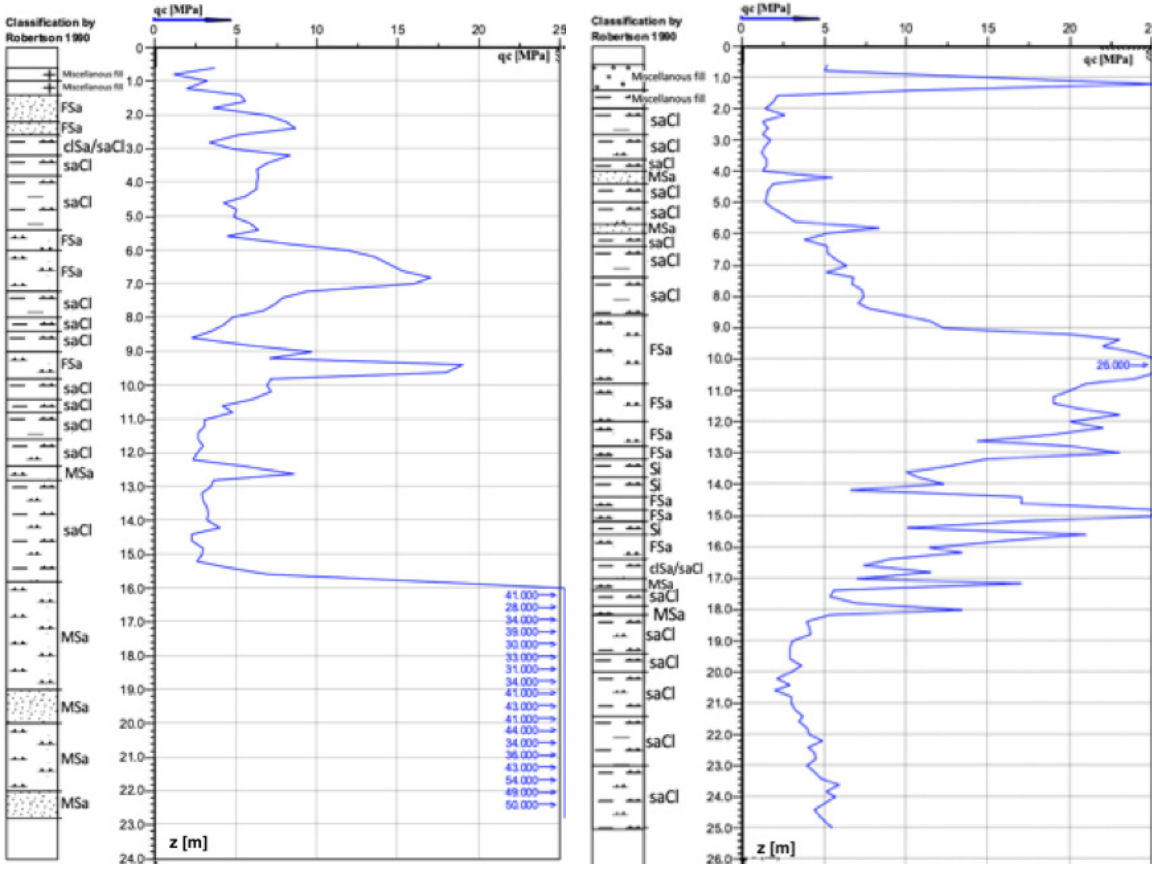
Figure 3: Graph of CPTu investigation results for Pile 1 (left graph) and Pile 2 (right graph) [9].